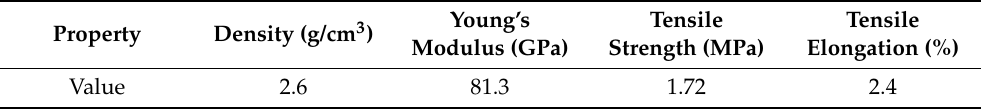
Table 4. E-glass (woven) properties.